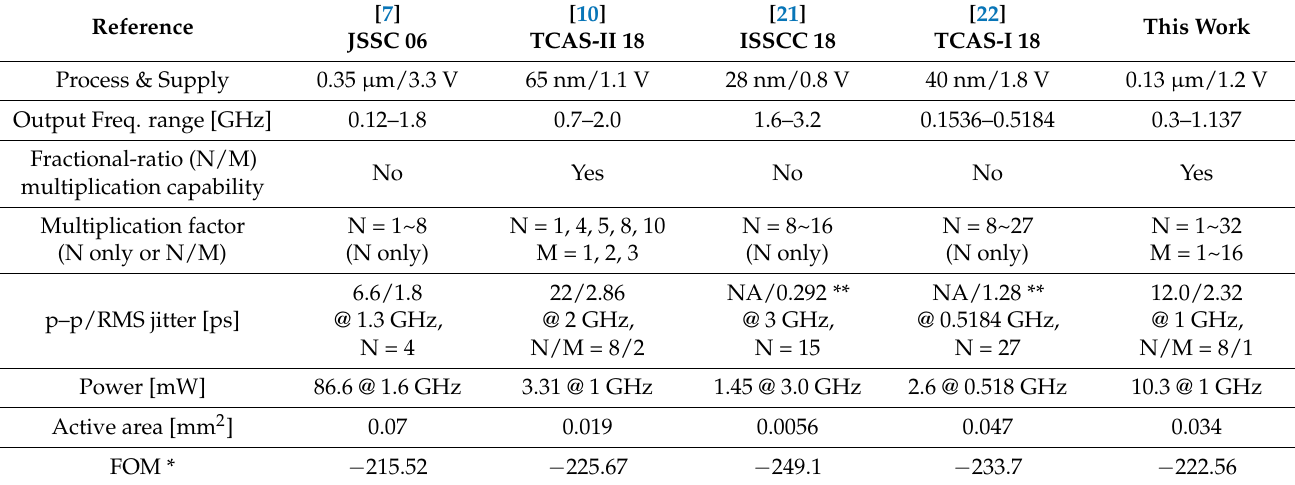
Figure 11. Measured input and output clock’s p-p/RMS jitter characteristics of the proposed digital MDLL (@ 1 GHz, N/M = 8/1). Table 1. Digital MDLL performance summary and comparisons.